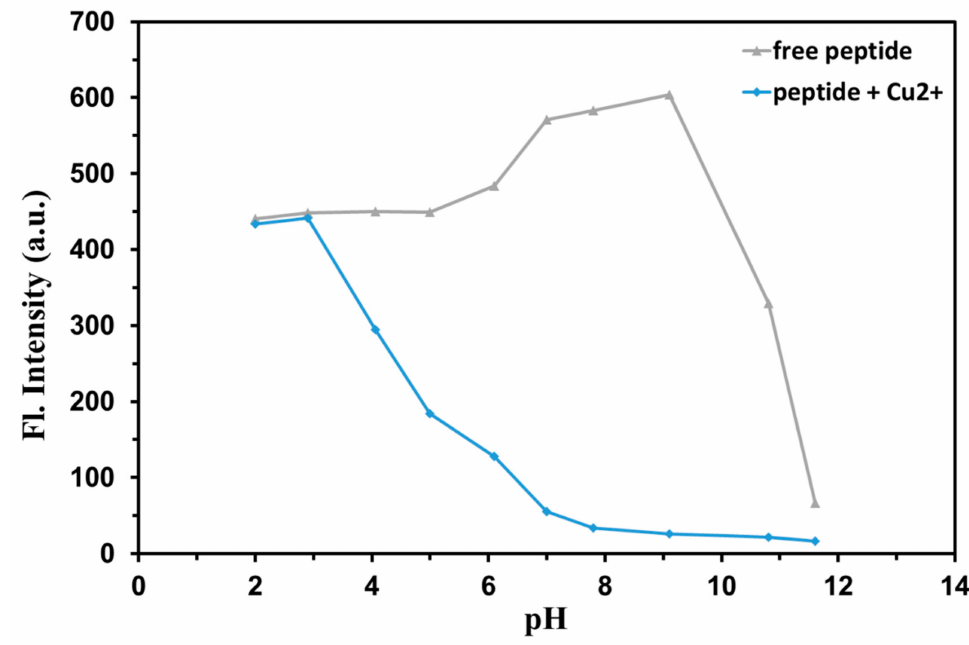
Figure 6. The pH influence on the fluorescence intensity of EHYHQ (0.1 mM) in the absence and presence of 80 µ M of Cu 2 +